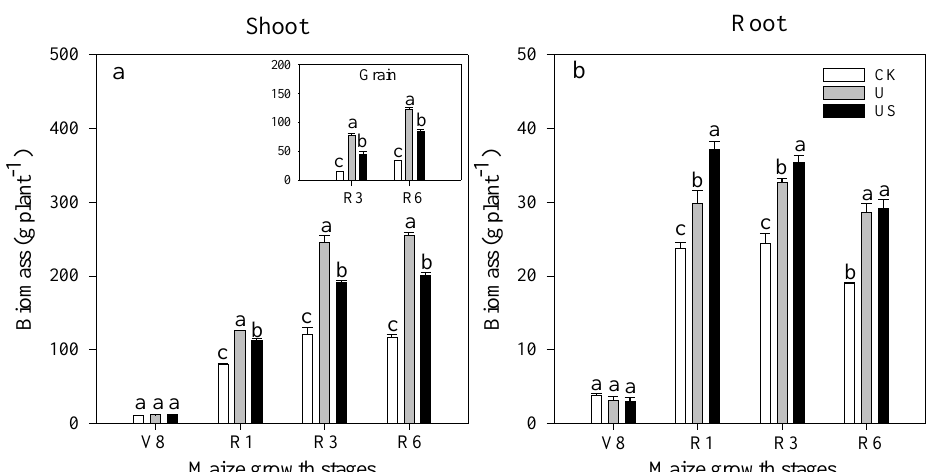
Figure 1. Biomass of maize shoots ( a ), grains, and roots ( b ) among control (CK), urea (U), and urea plus straw (US) treatments during maize growth stages of 8th leaf (V8), silking (R1), milk (R3), and physiological maturity (R6). Data shown are mean ± standard deviation of three replicates. Each replicate in US treatment was the mean of 15 N labeled urea plus straw and 15 N labeled straw plus urea treatments. Different letters indicate significant differences among treatments at p < 0.05. Shoot biomass includes leaf, stem, cob, husk, and grain fractions (all whole-plant fractions except roots).